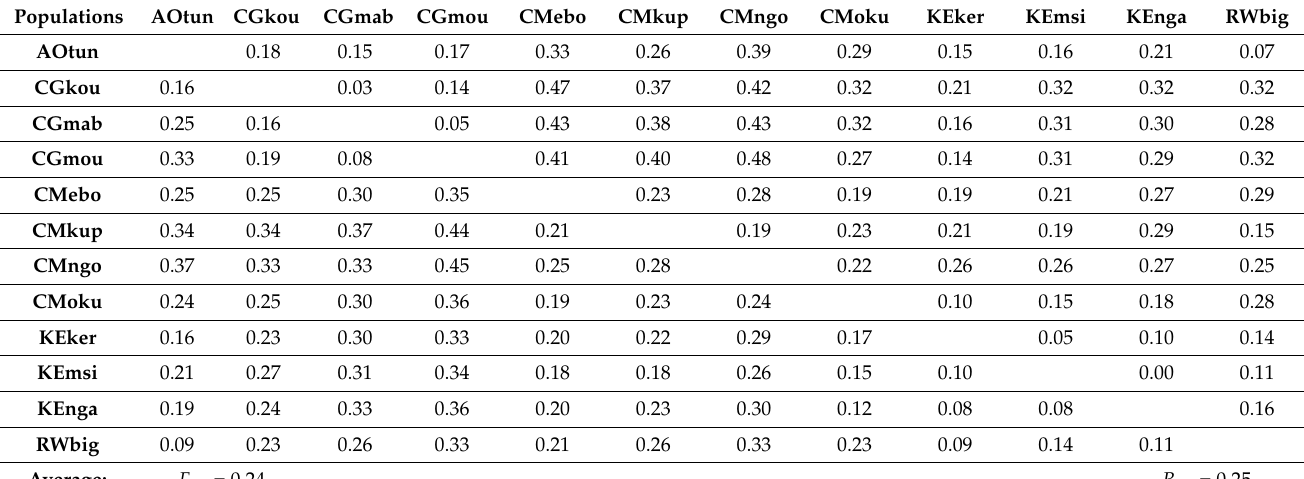
Figure 2. Fine-scale spatial genetic structure within populations of P. latifolius in Cameroon (CM), Republic of the Congo (CG), and Kenya (KE) assessed by kinship-distance decay for populations with more than 30 individuals sampled (Oku in CM, Maba Moubou and Kouyi in CG, Kereita and Taita Hills, combining KEnga and KEmsi, in KE). Table 2. Genetic differentiation between 12 P. latifolius populations at nine nuclear SSR loci: F ST (below diagonal) and R ST (above